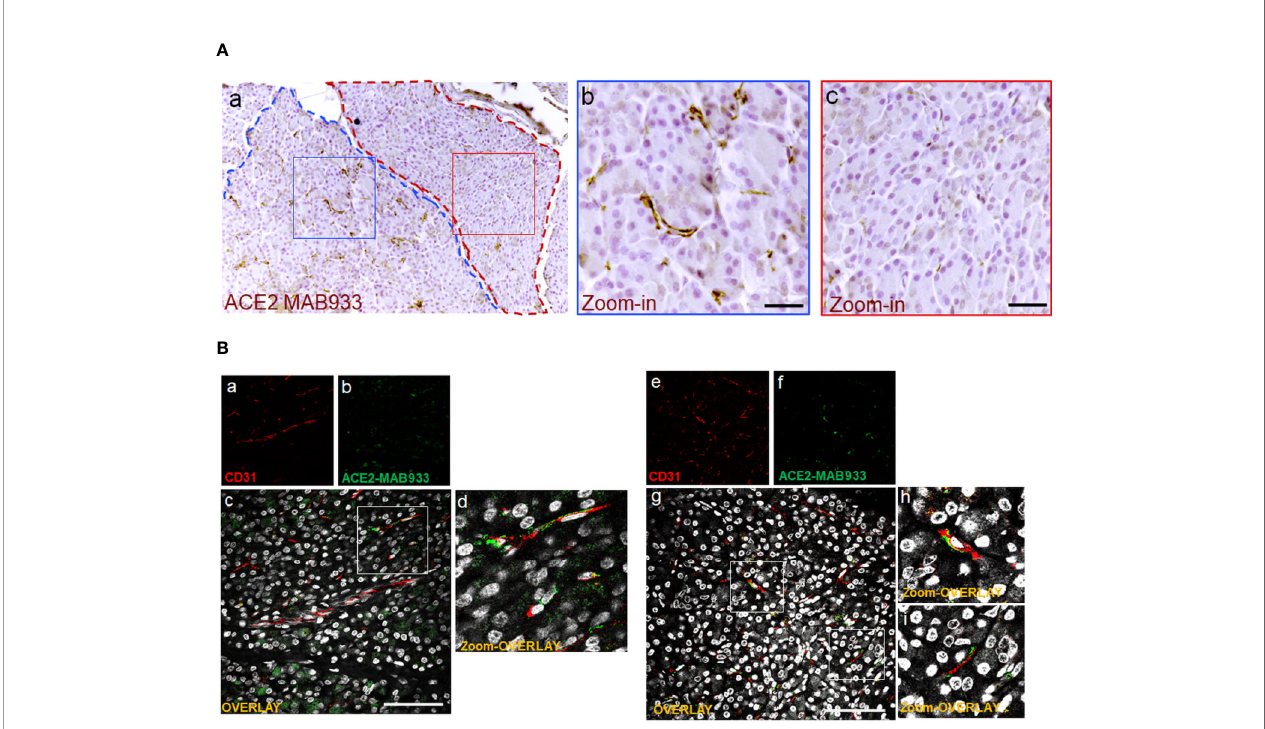
FIGURE 2 | In microvasculature, ACE2 is putatively expressed in pericytes. (A) Representative image of human pancreatic Formalin-Fixed Paraf fi n Embedded (FFPE) section stained for ACE2 in case #301118. In panel-a, a representative image of a pancreatic section showing two adjacent lobules (blue and red dotted lines) with different staining for ACE2 in endothelial cells/pericytes. A speci fi c segmentation of the two lobules with high (blue) (zoom-in, panel-b) and low or null expression of ACE2 (red) (zoom-in, panel-c) is shown, suggesting lobularity of ACE2 expression in exocrine endothelial cells/pericytes of human pancreas. Scale bar in panel-a: 100 µm. Scale bar in panels-b and -c: 30 µm. (B) Double immuno fl uorescence staining of ACE2 (green) and CD31 (red) in FFPE pancreas sections from Body01A of Case #110118 (panels-a to -d) and of Body01B of Case #141117 (panels-e to -i). Digital zoom-in overlay images are shown in panels-d, -h and -i. Scale bar in panels-d and -g: 100 m plasma membrane ( Figure 4A; Figure S5A red arrow, and Figure S5B ). In microvasculature pericytes, the ACE2-positive signal was mainly observed in plasma membrane ( Figure 4A , panel-g; Figure S5A green arrow) as previously described (43).